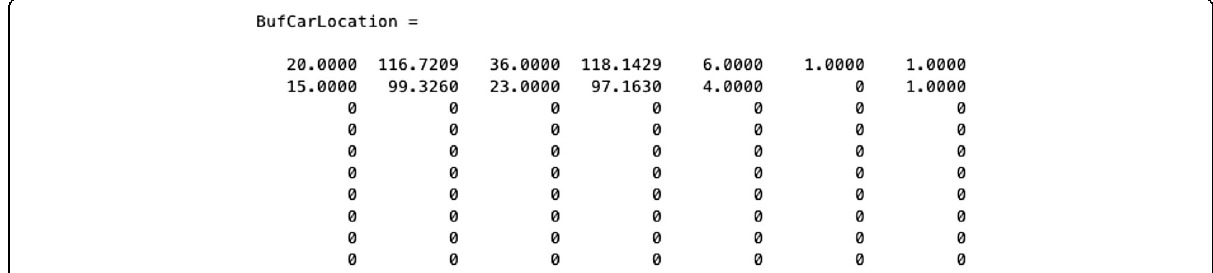
Fig. 15 Rows reshuffling after first vehicle disappearance in scene